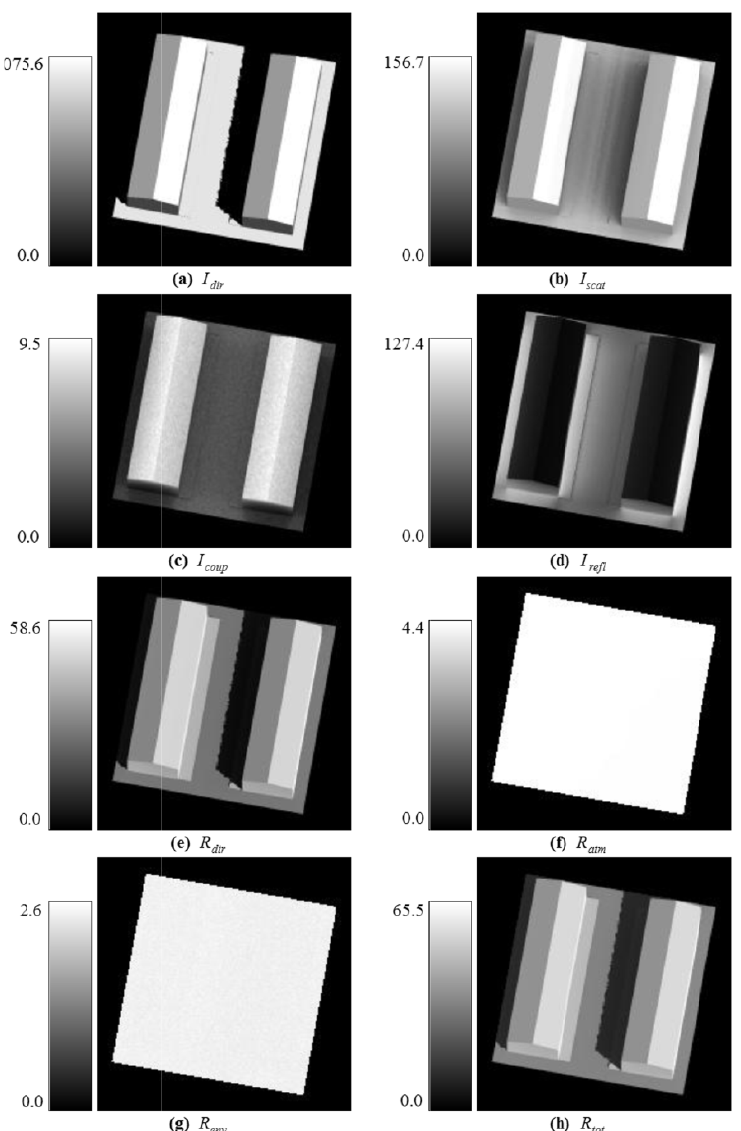
nd irradianc at 670